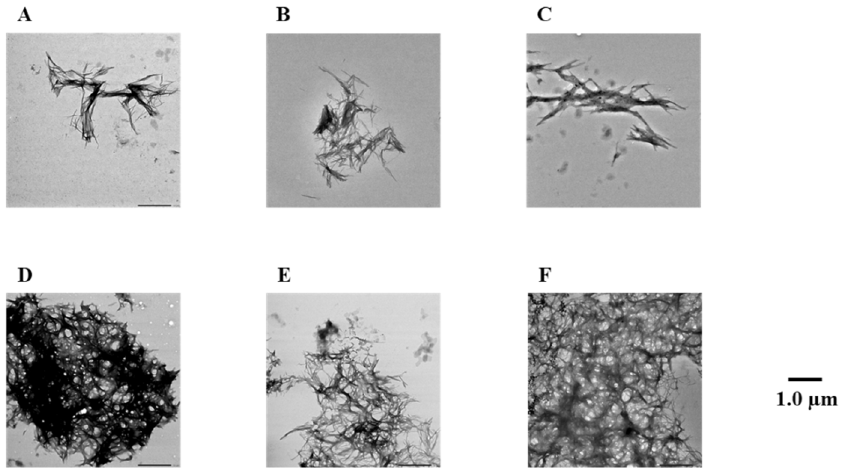
Figure 5. Efficacy of compounds 1 , 3 , 5 , 7 , and 8 against hIAPP fibril formation visualized by use of TEM. The formation of hIAPP fibrils was observed after incubation in 50 μ M PBS buffer for 24 h. Scale bar: 1.0 µ M. ( A ) hIAPP + 1 , ( B ) hIAPP + 3 , ( C ) hIAPP + 5 , ( D ) hIAPP + 7 , ( E ) hIAPP + 8 , and ( F )